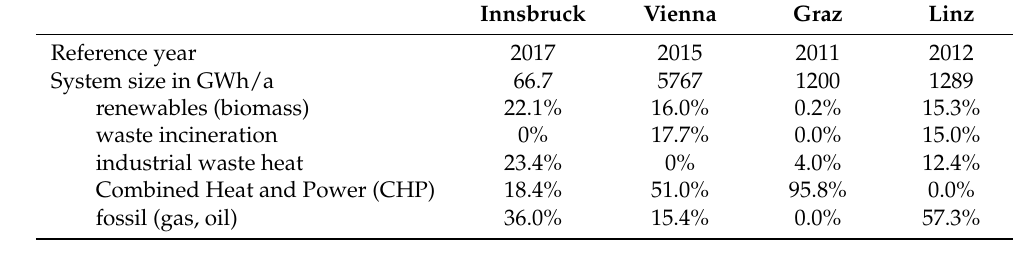
Table 1. Share of renewables in DH in %, examples from Austria, acc. to [13].